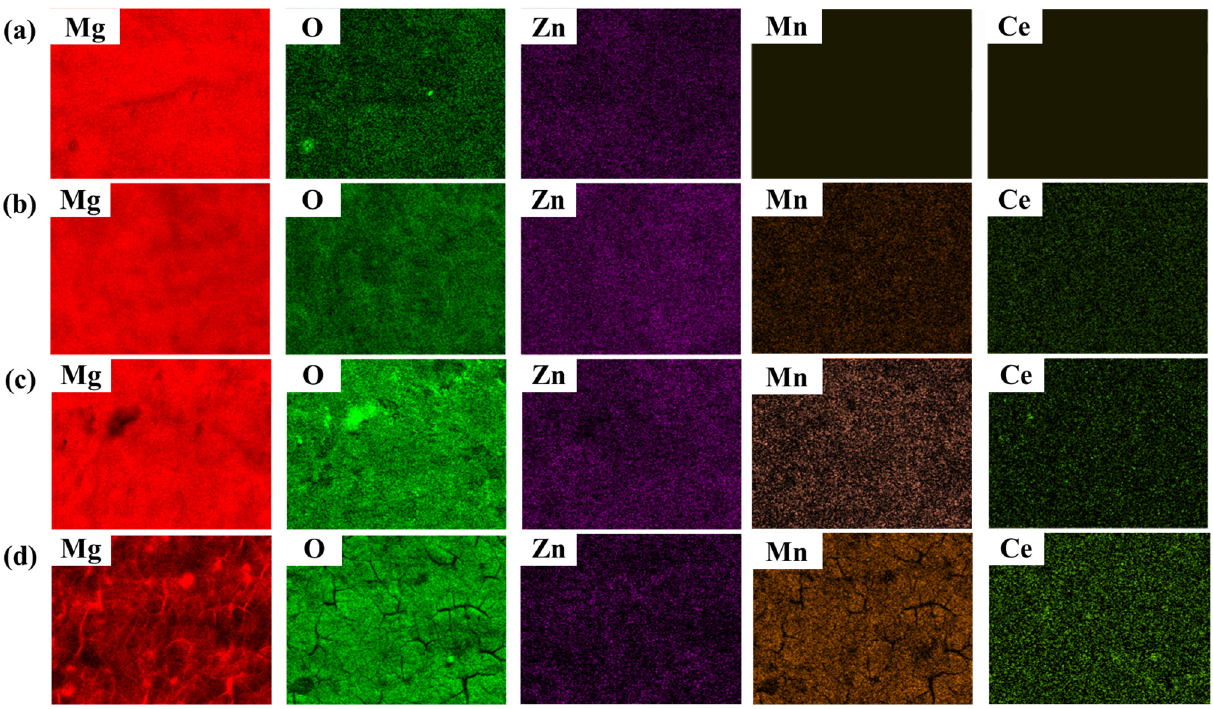
Figure 7. EDS/elemental mapping of the surface morphology image of LZ91 Mg alloy after conver- sion coating treatment for ( a ) 1 s, ( b ) 5 s, ( c ) 10 s, and ( d ) 30 s. Table 2. Results for EDS for LZ91 Mg alloy after conversion coating treatment.